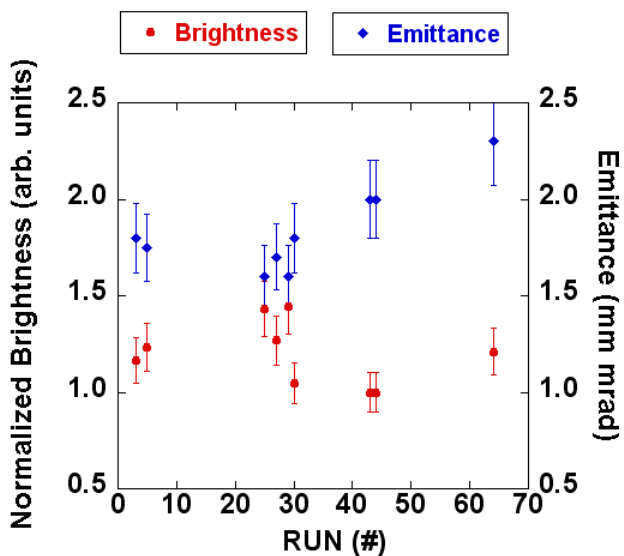
FIG. 16. (Color) Vertical emittance and brightness normalized to their design values, in the cases with peak brightness larger than its design value ( 5 (cid:4) 10 13 A = m 2 ).